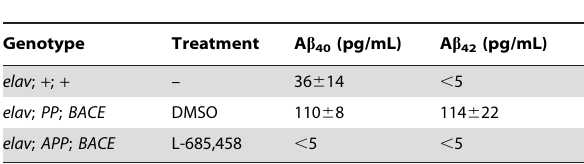
generated a CTFwas detected (Figure 1, red arrow in second lane).